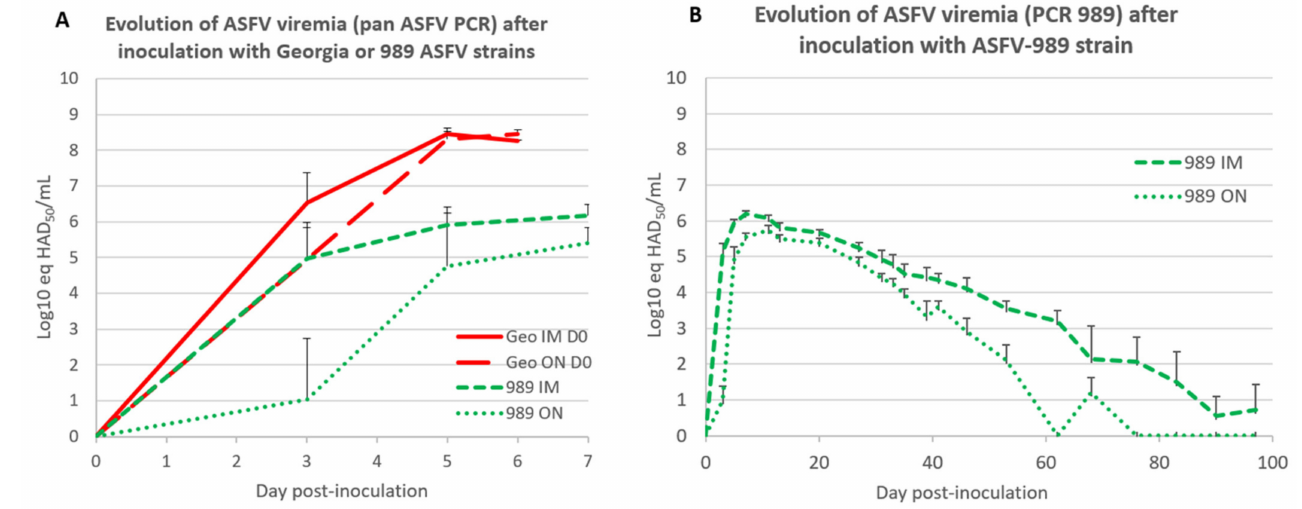
Figure 4. Evolution of ASFV viremia after Georgia or ASFV-989 strain inoculation. ( A ) Evolution of ASFV viremia (Log10 eq HAD 50 /mL) after inoculation with Georgia or ASFV-989 strains using a qPCR test [41] that detect both ASFV-989 and Georgia strains (time in days post-inoculation). Geo IM—data from groups E and F; Geo ON—data from groups F and J; 989 IM—data from groups C and D; 989 ON—data from groups B, H, and I. ( B ) Evolution of ASFV viremia (PCR 989,